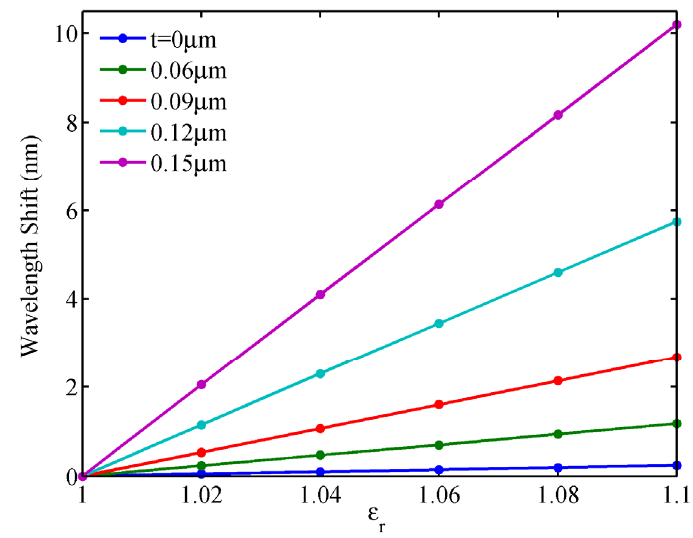
Figure 9. Surface sensing. Relation between NPM layer